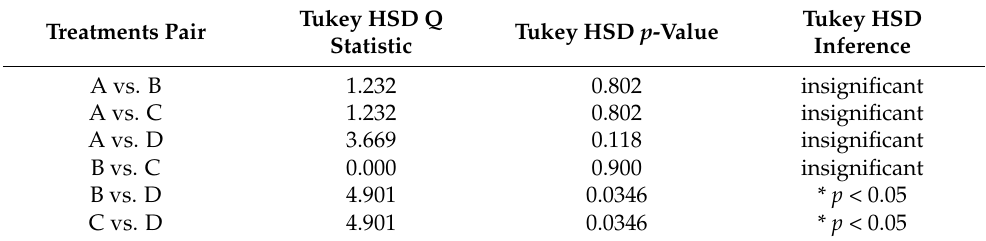
Table 5. Tukey results for pairwise comparison of treatments on bulk density.